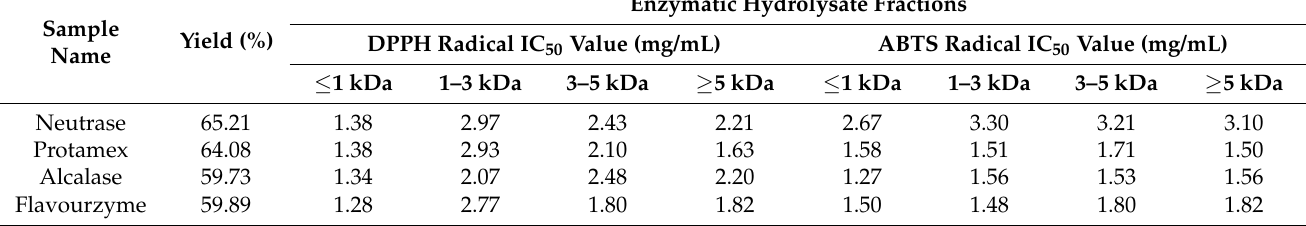
Table 1. Enzymatic hydrolysate yield (%) and molecular weights of fractions (kDa) with IC 50 values (mg/mL) indicate ABTS and DPPH radical scavenging activity